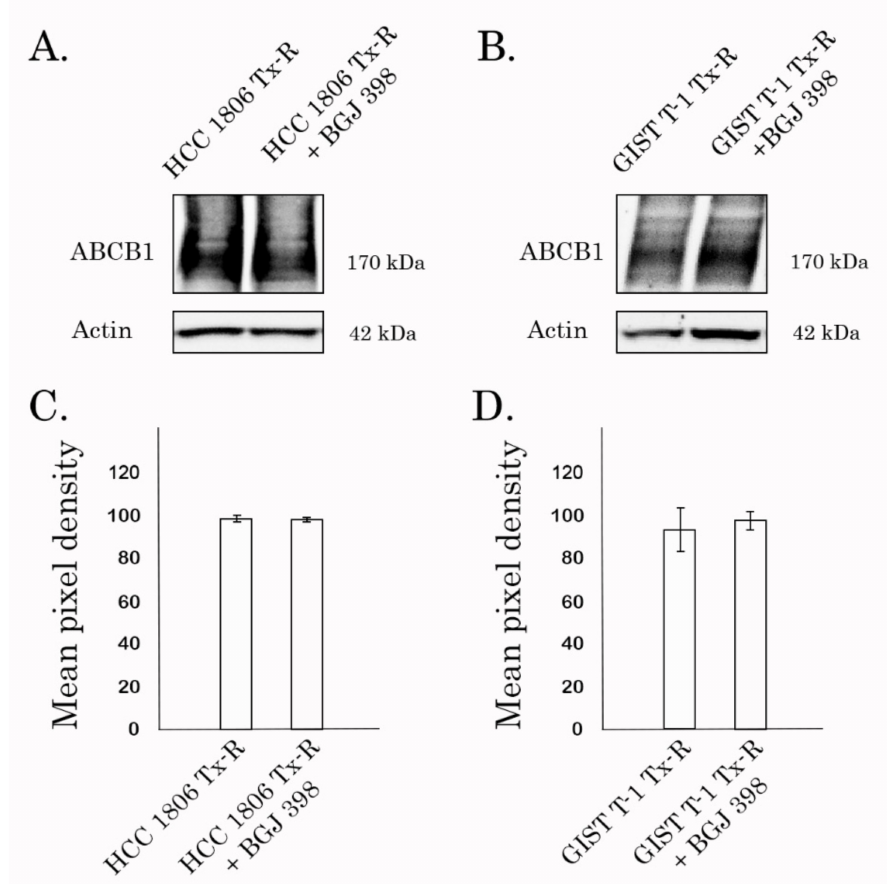
Figure 10. Expression of ABCB1 in Tx-R HCC 1806 ( A ) and GIST T-1 ( B ) cancer cells treated with DMSO (control) and BGJ398 for 72 h. Actin stain was used as a loading control. Actin stain was used as a loading control. ( C , D ) Quantification by mean pixel density of ABCB1 in Tx-R HCC 1806 cells ( C ) and GIST T-1 ( D ) cancer cells after treatment as indicated above. Values are means ± SD, n = 3. Statistically significant differences were not